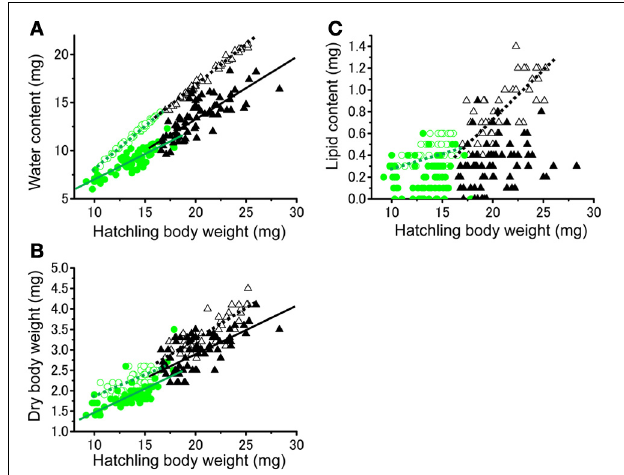
FIGURE 7 | Relationship between hatchling body weight at hatching and water contents (A), dry body weight (B), and lipid contents (C) of either solitarious ( (cid:2) , • ) or gregarious hatchlings ( (cid:2) , (cid:3) ) of Schistocerca gregaria pre- ( (cid:2) , (cid:2) ) or post- ( • , (cid:3) ) starvation. Regression lines are drawn when significant (green for the solitarious, black for gregarious, dotted line for pre-starvation, solid line for post-starvation). See Table 3 for statistical results.